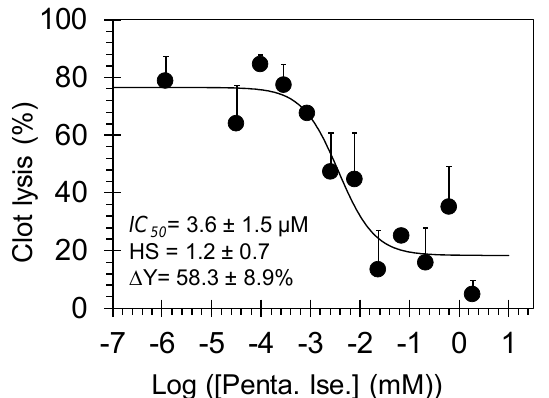
Figure 3. The dose-dependent inhibition of plasmin-mediated clot lysis by pentamidine isethionate. The effect was determined by measuring the ultraviolet (UV) absorbance of each well containing different concentration of pentamidine at 405 nm over a time period of 340 min. Solid line represents the sigmoidal dose–response fits (Equation (1)) for the data to obtain the values of IC 50 , HS, and ∆ Y (%). Given also are the standard error bars (±1 SE).